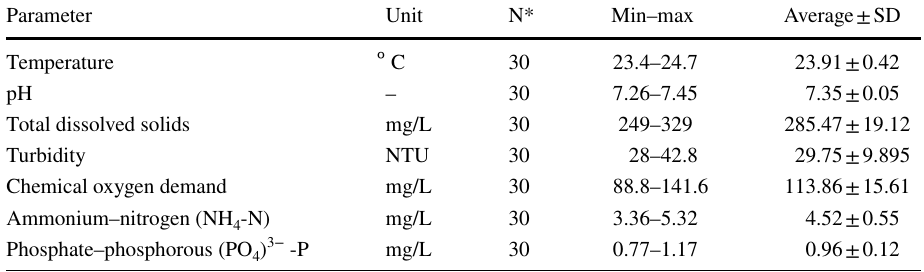
Table 1 Untreated greywater